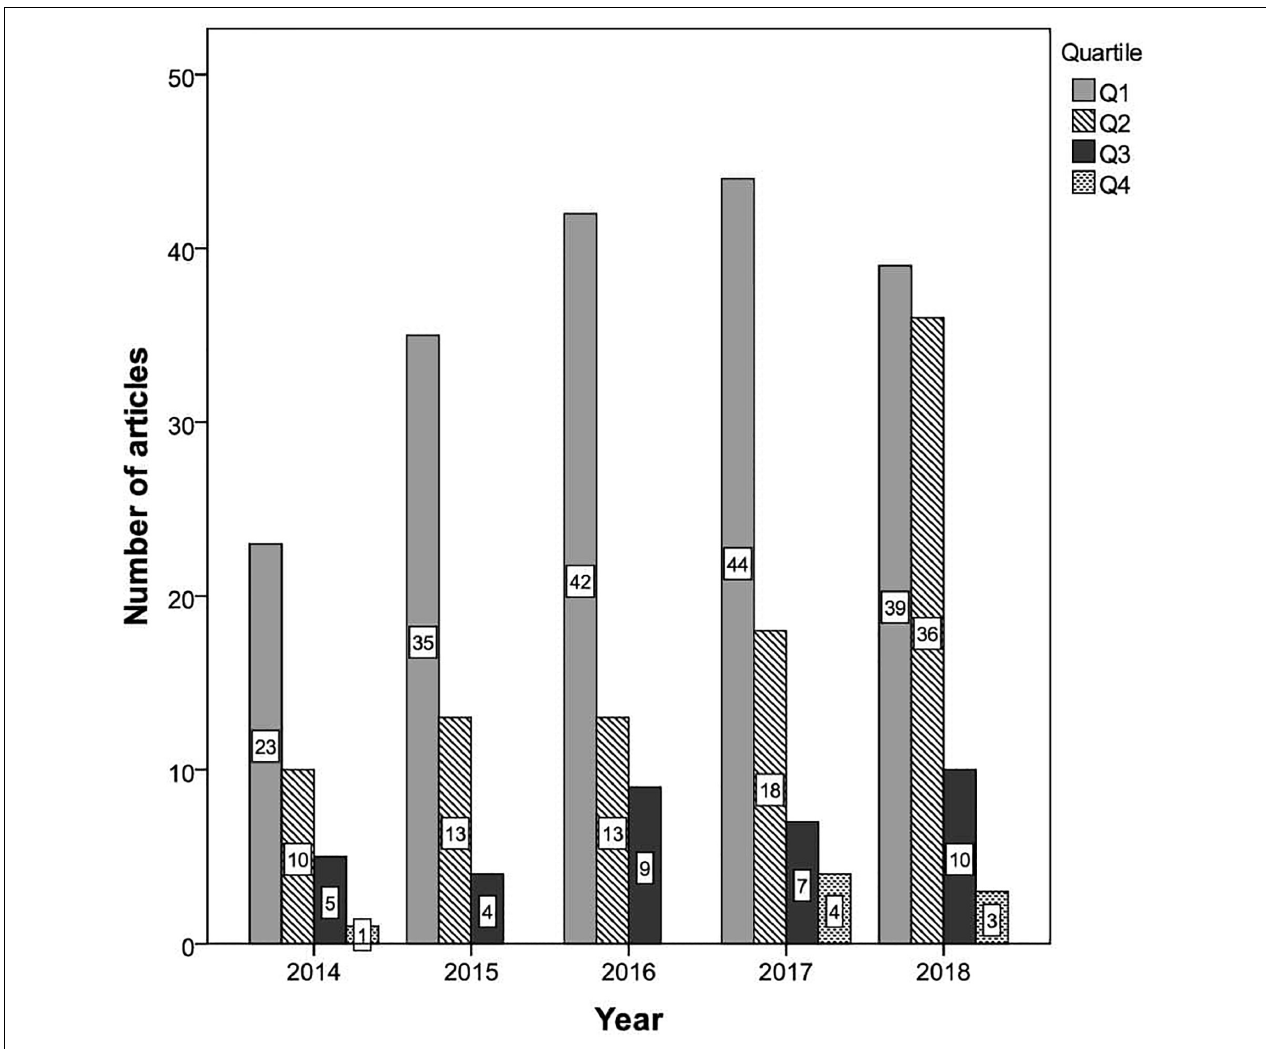
FIGURE 4 | Number of articles by journal quartile and publication